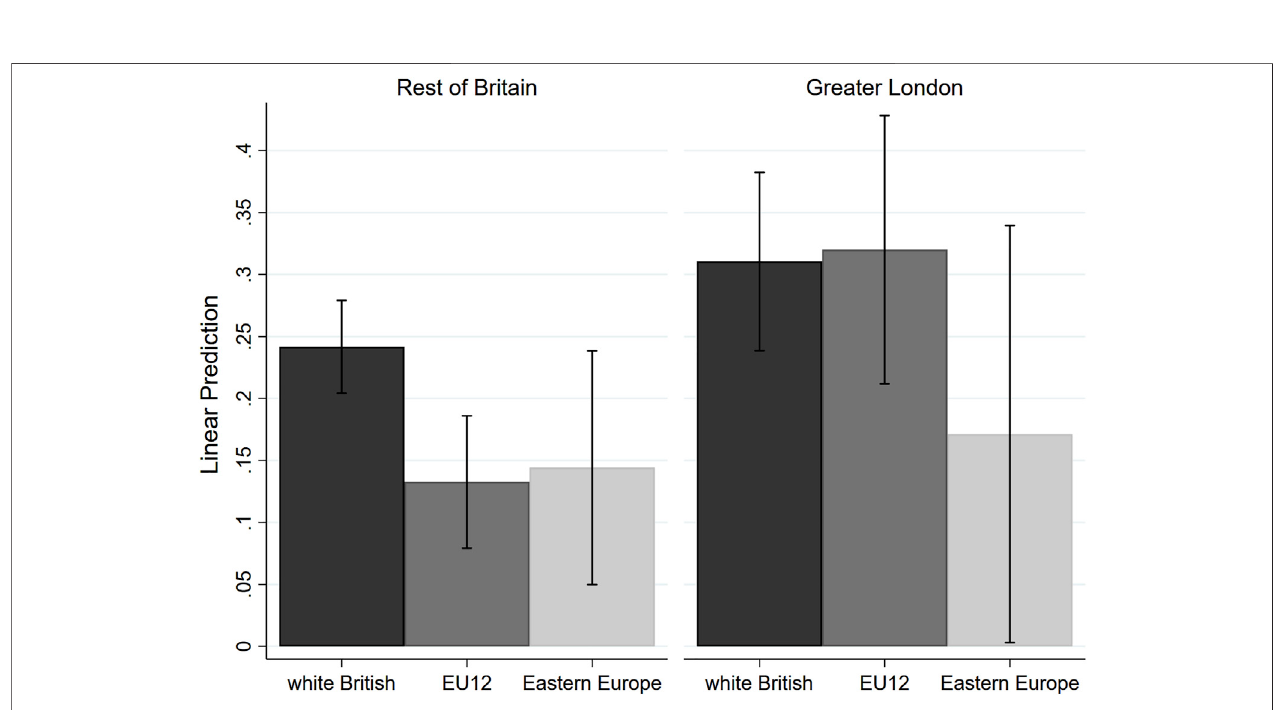
FIGURE 2 | Predicted callbacks (any interest), by group: London vs. rest of